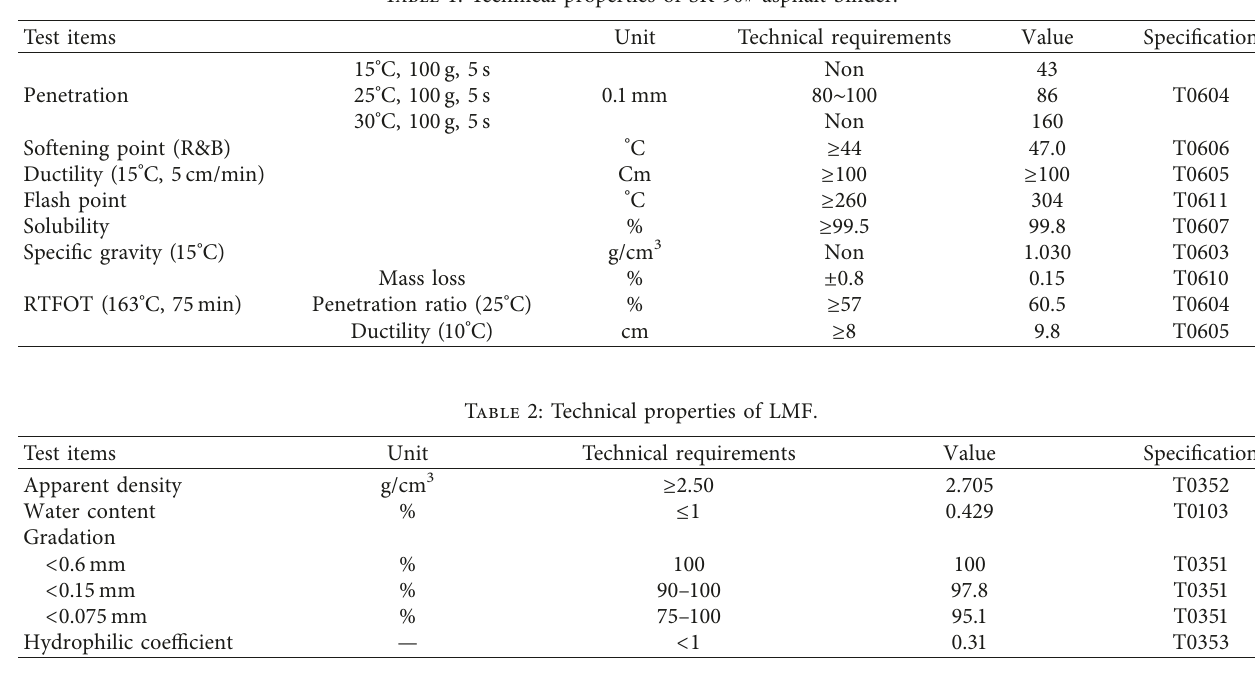
Table 1: Technical properties of SK-90# asphalt binder.